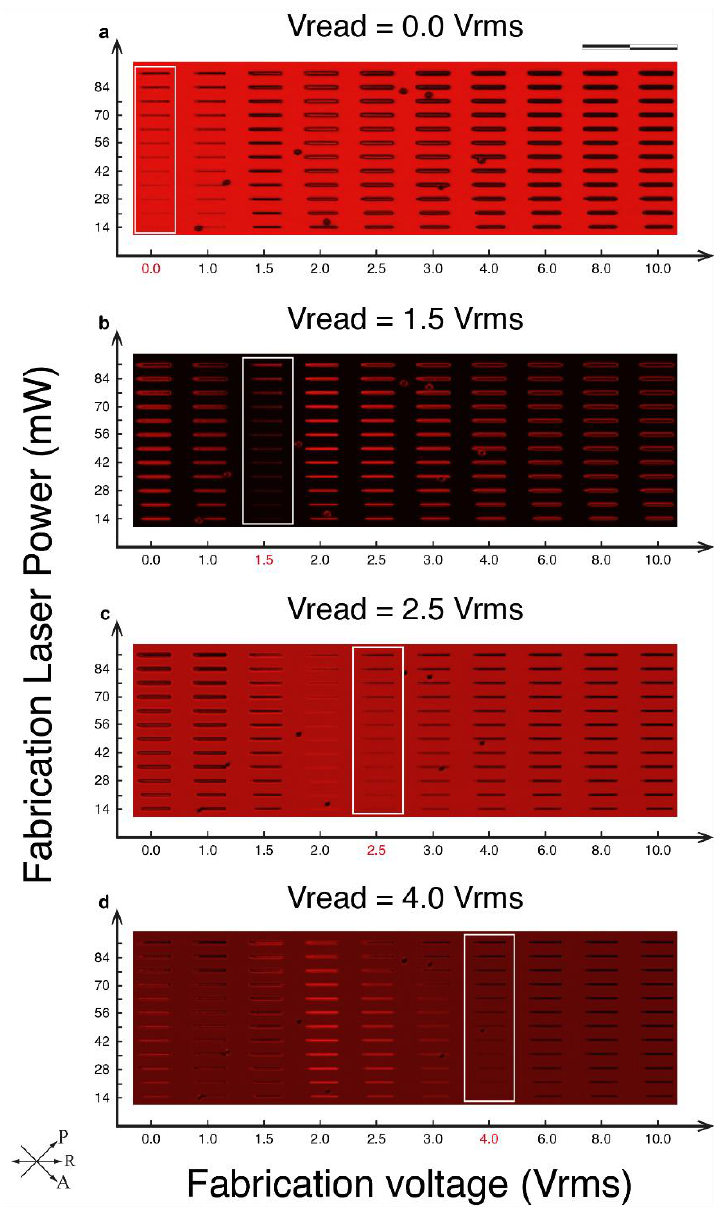
Figure 2. Laser written polymer walls in a polymerizable LC mixture for different fabrication laser powers and voltages applied to the LC during fabrication. The scale bar in the figure is 200 µm. The laser polarization was set to be perpendicular to the rubbing direction of the LC device. Images were recorded on a polarizing optical microscope when the rubbing direction was aligned at 45° to the transmission axes of the polarizer and analyzer pair, and with the aid of a narrow bandpass filter to remove all wavelengths beyond 640 nm – 660 nm to avoid any further polymerization post-fabrication.